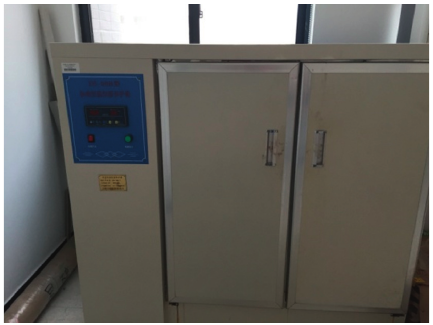
Figure 2: Constant temperature and humidity curing